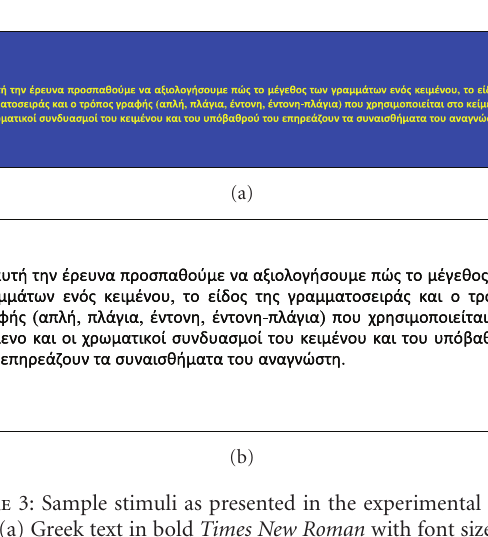
Figure 3: Sample stimuli as presented in the experimental proce- dure. (a) Greek text in bold Times New Roman with font size 16px and (b) Greek text in Times New Roman with font size 26 px. The translation of the text is: “In this study we are trying to assess how font size, font type and font style (plain, italics, bold, bold-italics) which are used in a text and the chromatic combinations of text and its background a ff ect reader’s